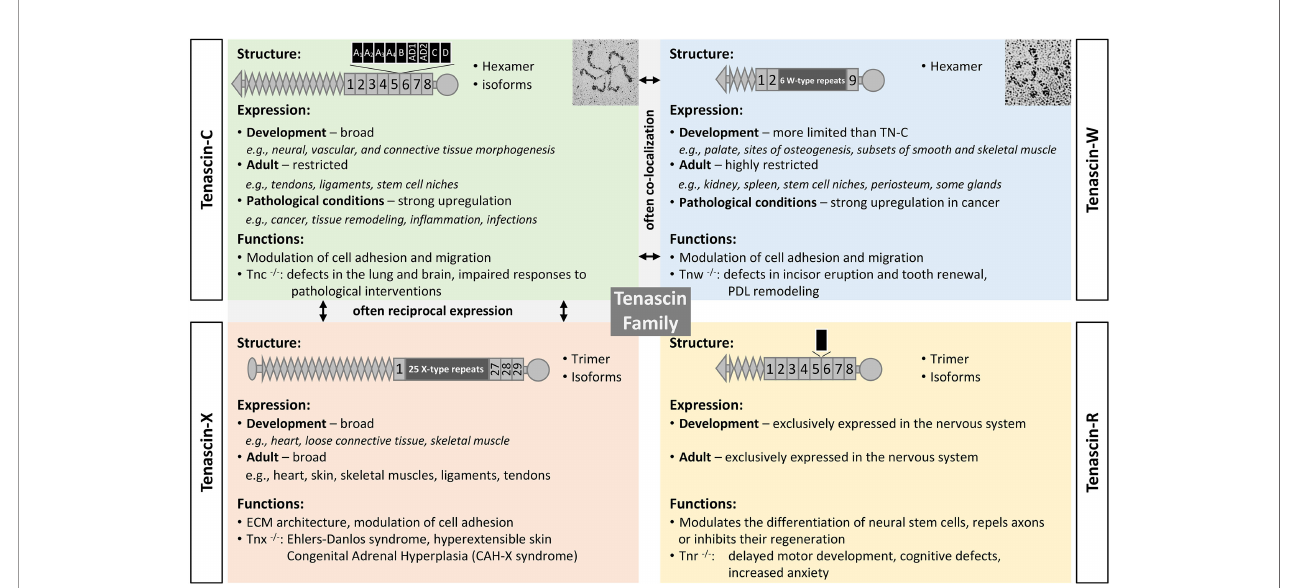
FIGURE 1 | The tenascin family. A brief description of the four tenascin members, including their structure and alternative splicing, major sites of expression, and functions. Original rotary shadowing micrograph for TN-C is from Chiquet-Ehrismann et al. (13) and for TN-W from Scherberich et al. (14) both with permission. The following symbols have been used to describe the structural domains: EGF-like domains (diamonds), FNIII domains (boxes), fi brinogen globe (circle). FNIII repeats shown above the structure are subject to alternative splicing (black boxes). Selected references: for TN-C (15 – 17), TN-X (18 – 21), TN-R (22 – 24), TN-W (25 – 27), and for tenascins in general (28 –